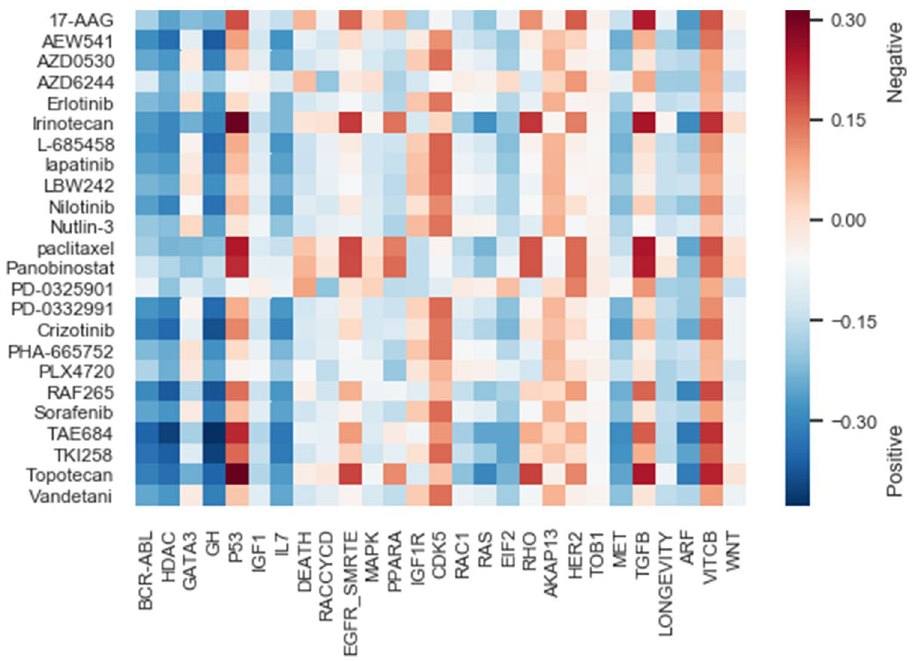
Figure 7. Correlation of pathway activity scores and drug responses. The drugs are shown in rows, and pathways are shown in columns. The positive correlations are represented in red and negative correlations are represented in blue. The intensity of the color indicates the extent of correlation.